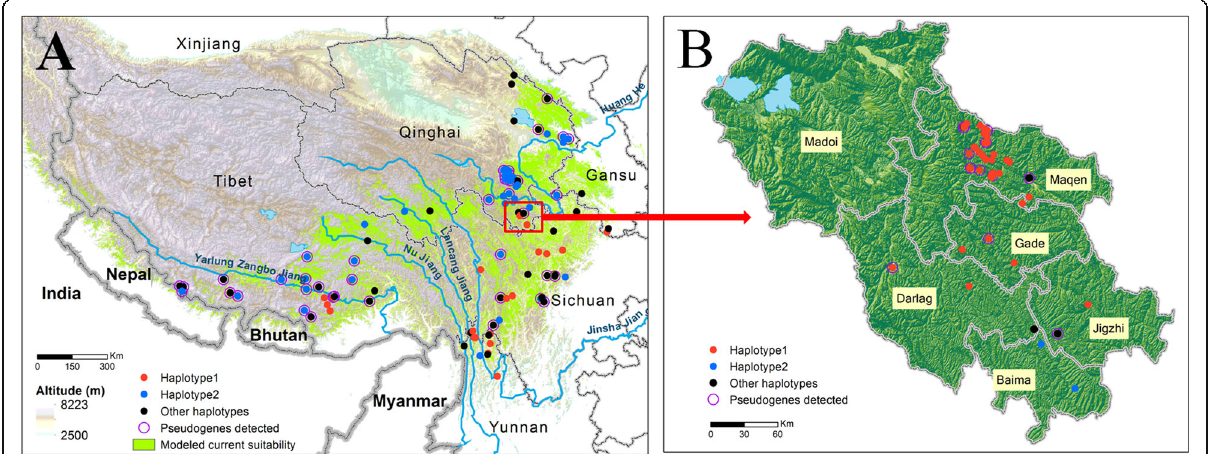
Fig. 1 Sampling and detection of ITS pseudogenes in populations of Ophiocordyceps sinensis in China ( a ) and Guoluo, Qinghai ( b ), respectively. Red spots indicate the dominant ITS haplotype (haplotype 2), blue spots indicate ITS haplotype (haplotype 1) with the epitype designated by Li et al. (2013) and black spots indicate other haplotypes. Purple cycles indicate the detection of ITS pseudogenic